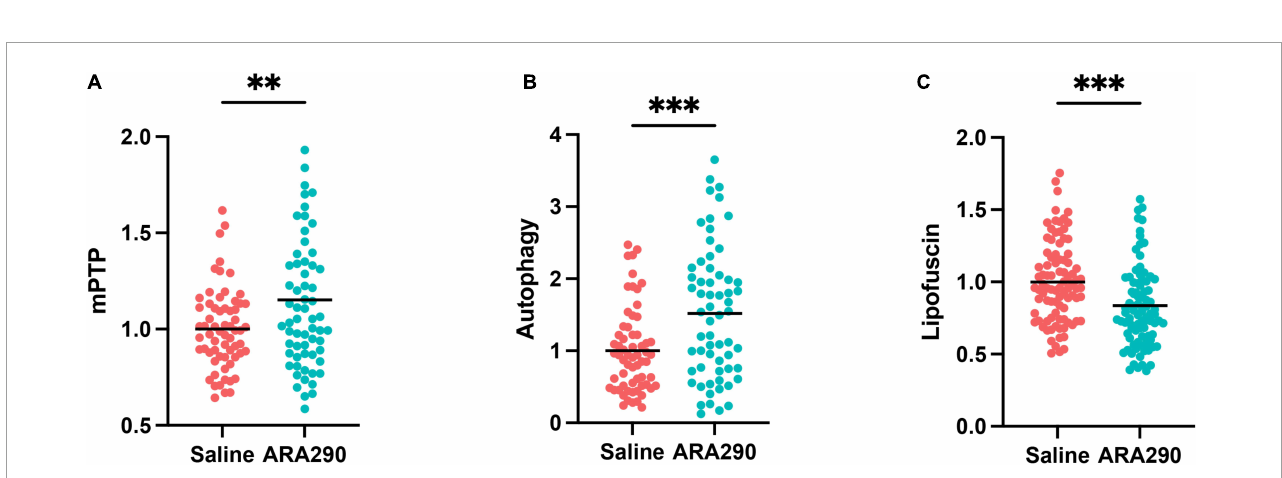
FIGURE7 The mitochondrial permeability transition pore (mPTP) opening thresholds (A) , cardiomyocyte autophagy flux (B) , and accumulation of lipofuscin (C) in left ventricular cardiomyocytes isolated from 32-month-old rats. Statistically significant interactions between treatment groups are shown ( ∗∗ P < 0.01, ∗∗∗ P <